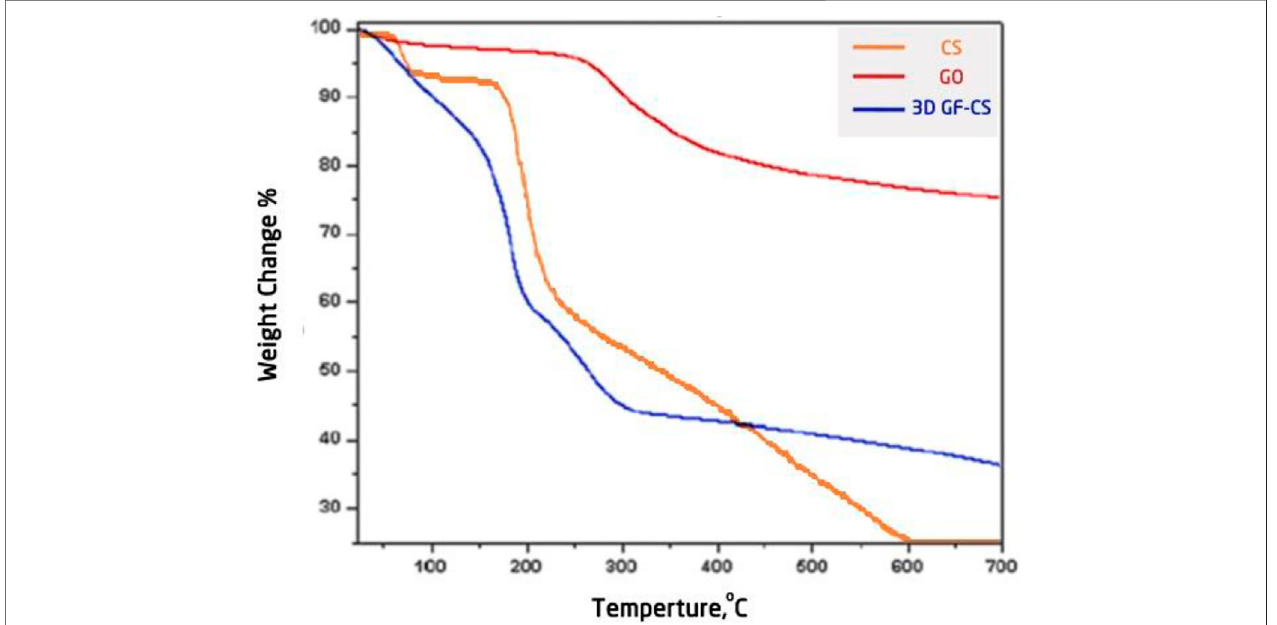
FIGURE 8 | Thermogravimetric analysis (TGA) thermogram of Cs, GO, and 3D GF-CS.